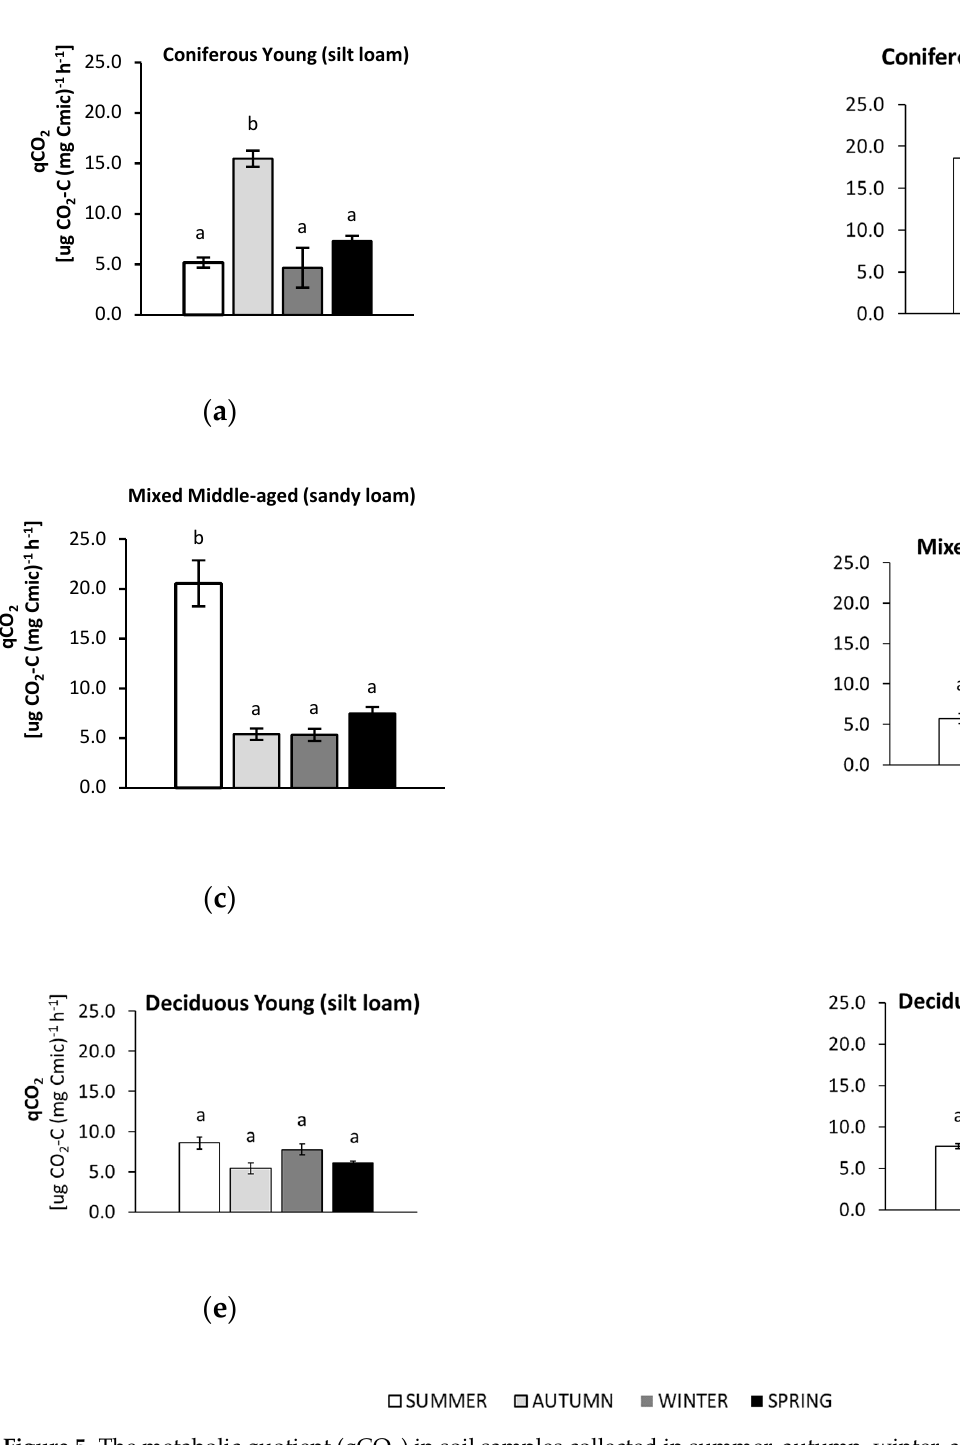
Figure 5. The metabolic quotient (qCO 2 ) in soil samples collected in summer, autumn, winter, and spring from different forests (average values ± standard deviation; n = 3). ( a ) Coniferous Young (silt loam); ( b ) Coniferous Mature (loam sand); ( c ) Mixed Middle-aged (sandy loam); ( d ) Mixed Mature (silt loam); ( e ) Deciduous Young (silt loam); ( f ) Deciduous Mature (silt loam). Different letters indicate significant differences (a non-parametric Kruskal–Wallis test, p < 0.05, was carried out separately for each season and for each forest).